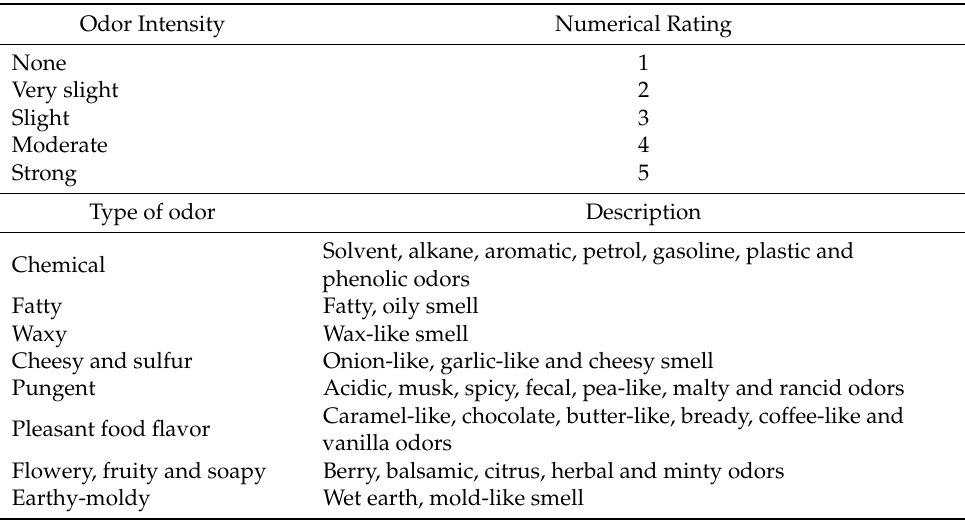
Table 2. Odor intensity rating scale and description of the perceived odors